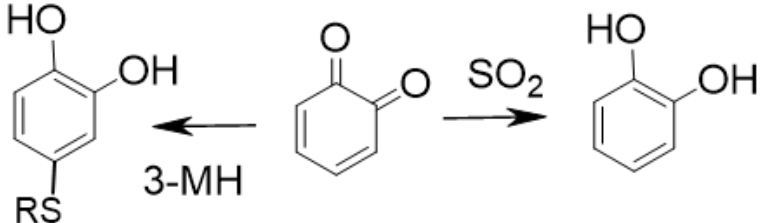
Figure 4. Quinones react quickly with desirable thiols such as 3-MH, but SO 2 can prevent the loss of 3-MH by reacting instead, acting as a sacrificial antioxidant.